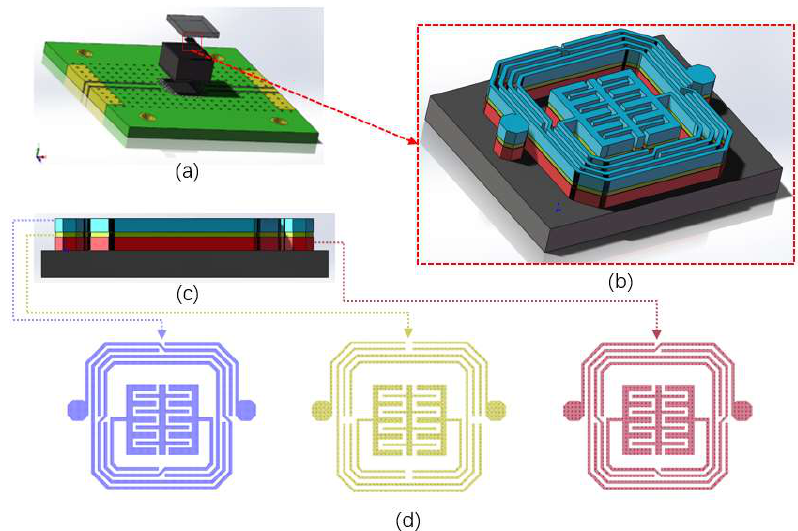
Figure 1. Design of the proposed bandpass filter (BPF): ( a ) 3D view of the packaged BPF on a printed circuit board (PCB) board; ( b ) enlarged view; ( c ) side view; ( d ) three metal layers (leads, text, and bond).